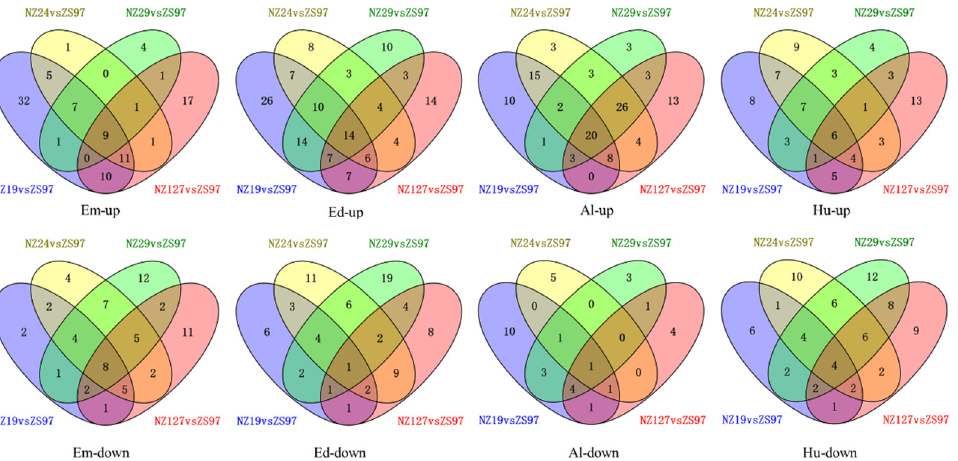
Figure 10. Venn diagram of different metabolites between four selected NILs (NZ19, NZ24, NZ29,